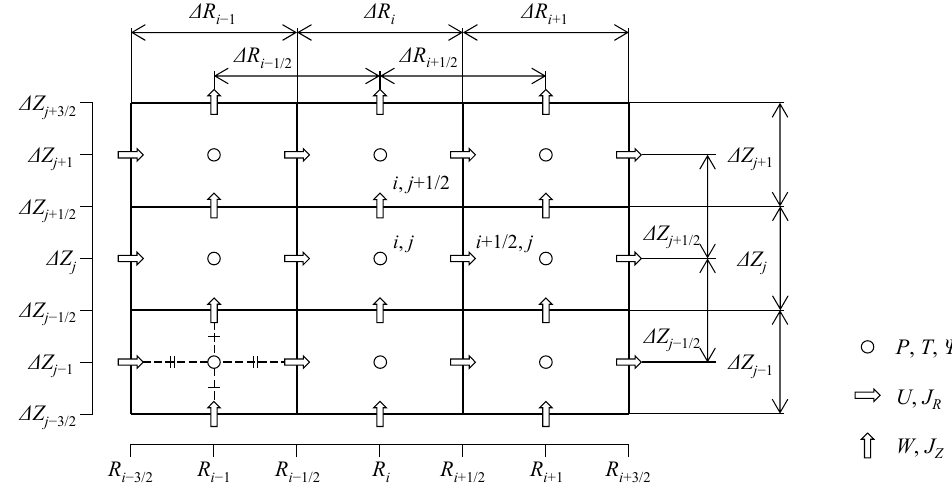
Figure 2. Staggered grid system.